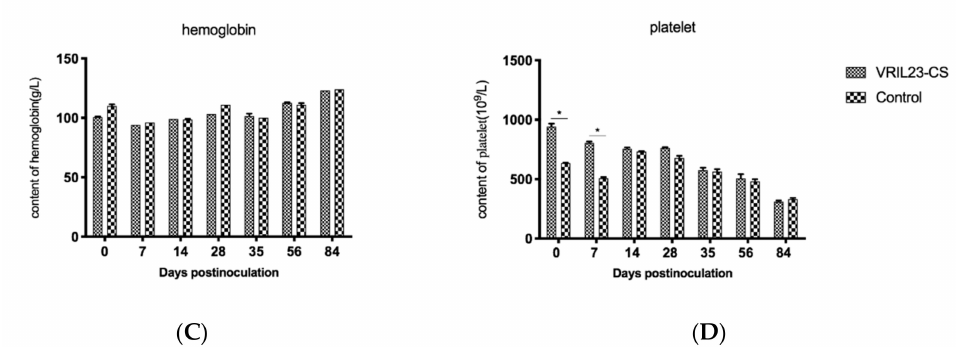
Figure 7. Changes in immune cells from the peripheral blood of the experimental pigs. ( A ) erythrocytes; ( B ) leukocytes; ( C ) hemoglobin; ( D ) platelet. * indicates the di ff erence between the two groups is significant, p < 0.05. The followings are the same as here.